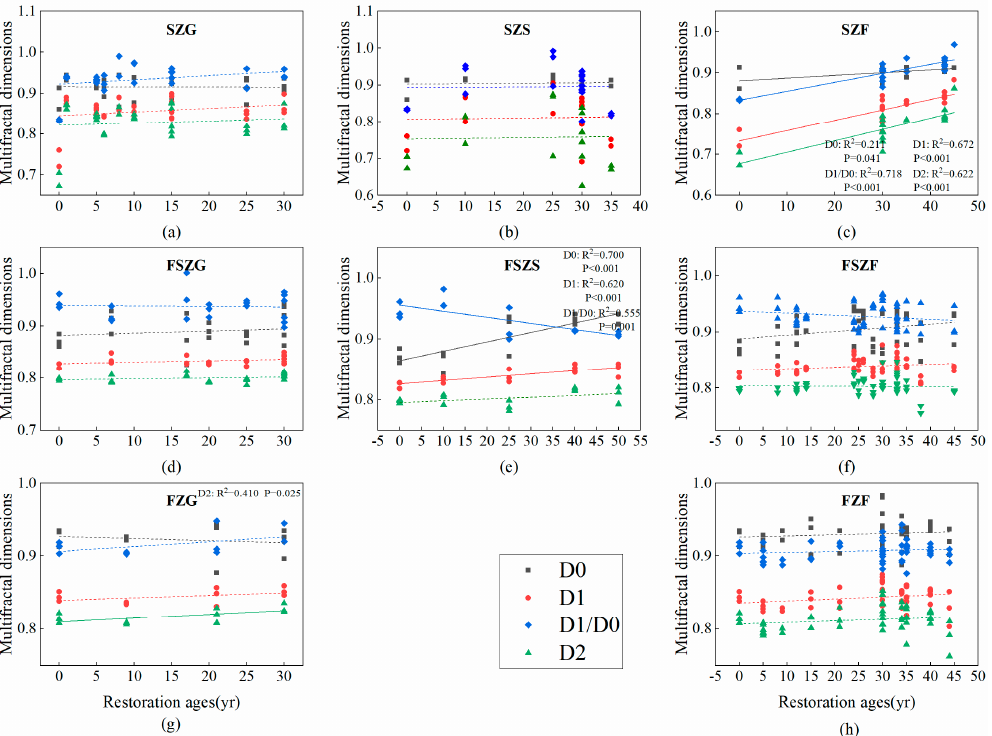
Figure 4. Changes to the soil multifractal parameters of the vegetation zones across the vegetation restoration chronosequence. ( a – c ) show changes to the soil multifractal parameters of SZG, SZS, and SZF with restoration age, respectively; ( d – f ) show changes to the soil multifractal parameters of FSZG, FSZS, and FSZF with restoration age, respectively; ( g – h ) show variation in soil multifractal parameters of grassland and forests with restoration age in the forest zone, respectively. D0: capacity dimension; D1: information dimension; D1 / D0: information dimension / capacity dimension ratio; D2: correlation dimension.